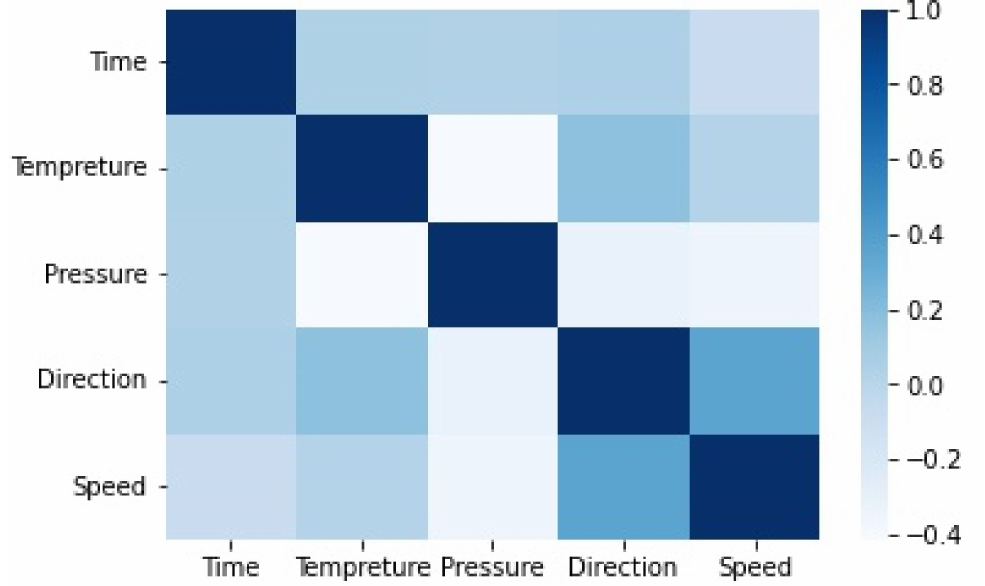
Figure 3. Dataset visualization using the